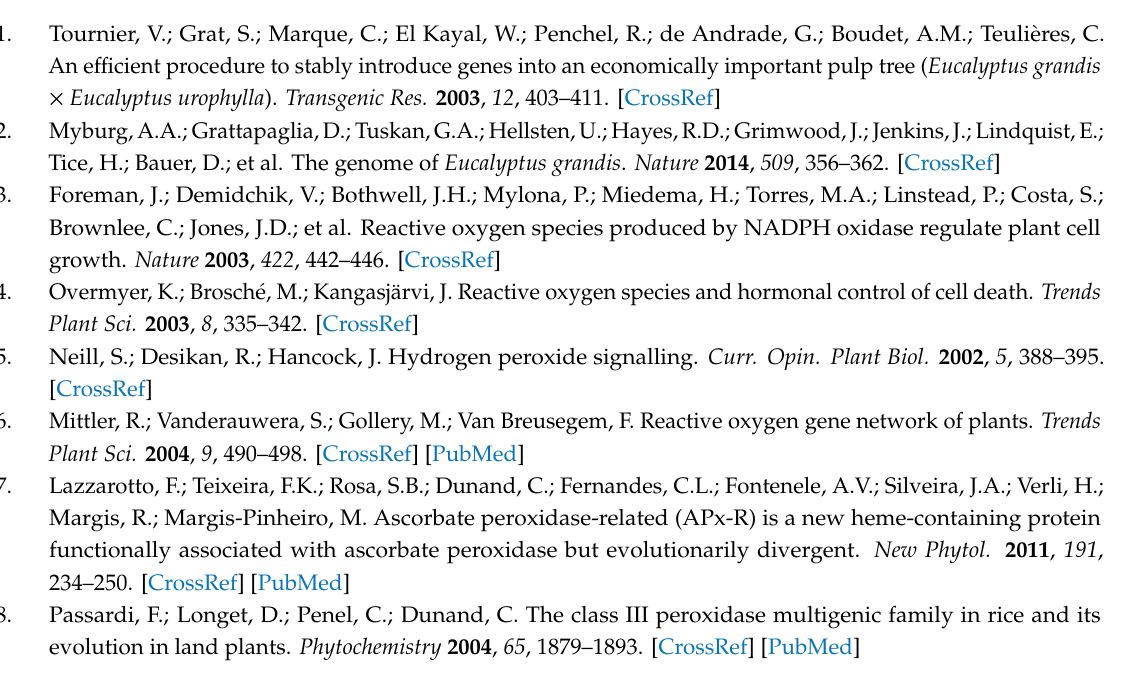
Table S1. List of the primers used in the exploration of the “missed” genes. Table S2. List of genes part of ROS gene network in E. grandis . Table S3. List of genes part of ROS gene network in E. camaldulensis . Table S4. List of genes part of ROS gene network in E. globulus . Table S5. List of genes part of ROS gene network in E. gunnii . Table S6. Corresponding gene by gene between the four E. species and A. thaliana . Table S7. Distribution and concentration of genes part of ROS gene network on the chromosomes. Table S8. List of ROS genes in A. thaliana . Table S9. RNA-seq data of ROS network in E. grandis . Table S10. EST number of each family in some organisms. Table S11. Evolutionary rate (Ka / Ks) of genes of CIII Prx and other families. Figure S1. Phylogenetic presentation (uncompressed) of all the ROS genes in E. grandis . Figure S2. Gene gain and loss during the evolutionary